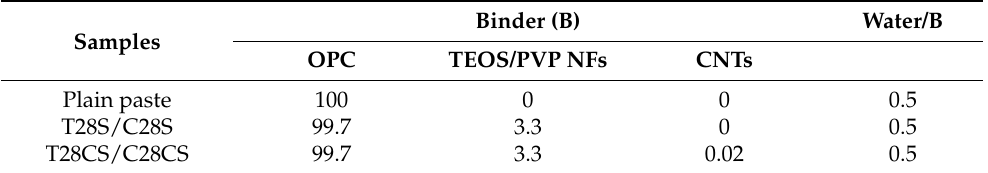
Table 5. Mix proportions of cement-based materials (by % mass).